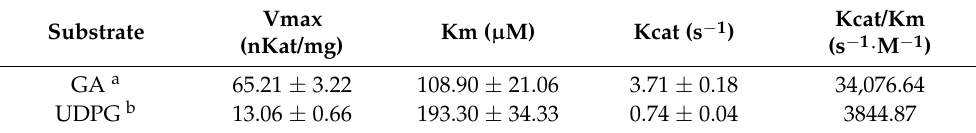
Figure 9. Enzymatic activity assays of recombinant UGT84A77 protein. ( a ) Identification of enzymatic products of UGT84A77 recombinant protein by UPLC-MS/MS; ( b ) the Michaelis–Menten curve obtained at different concentrations of GA; ( c ) the Michaelis–Menten curve obtained at different concentrations of UDPG. Table 1. Kinetic parameters of purified UGT84A77 recombinant protein for GA and 5 ′ -diphosphate glucose (UDPG).